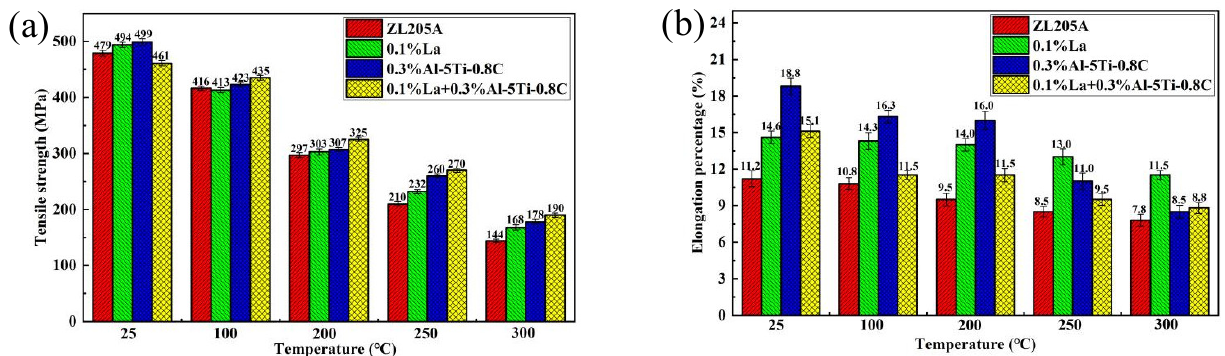
Figure 8. High-temperature mechanical properties of ZL205A alloy after T5 heat treatment: ( a ) tensile strength; ( b ) elongation.